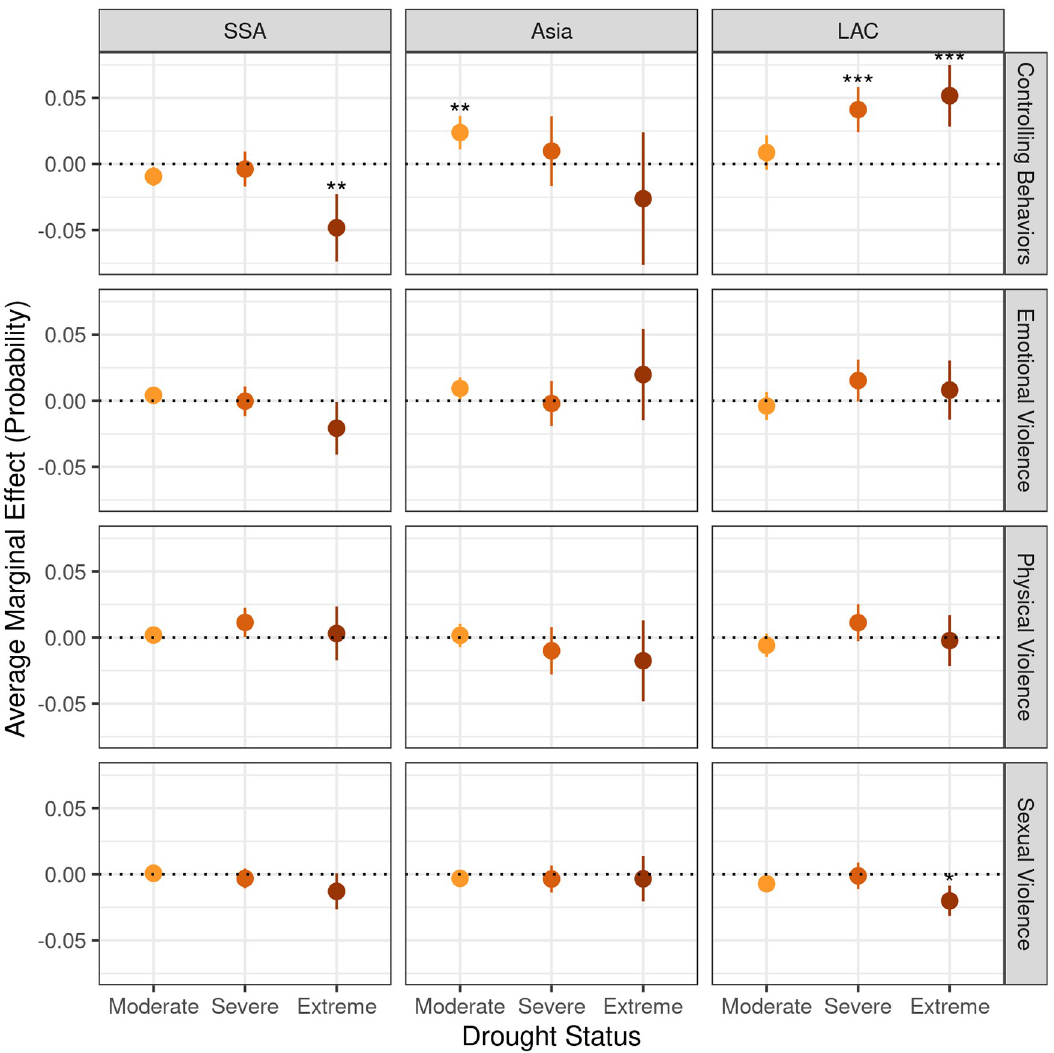
Fig 3. Effects of droughts on IPV. Average marginal effect of a moderate, severe, or extreme drought on a woman’s probability of experiencing IPV, relative to non-drought conditions, for all four types of IPV across three different sized data sets. Significance values are Bonferroni-corrected for testing 12 hypotheses, so � p < 0.05/12, �� p < 0.01/12, ��� p <